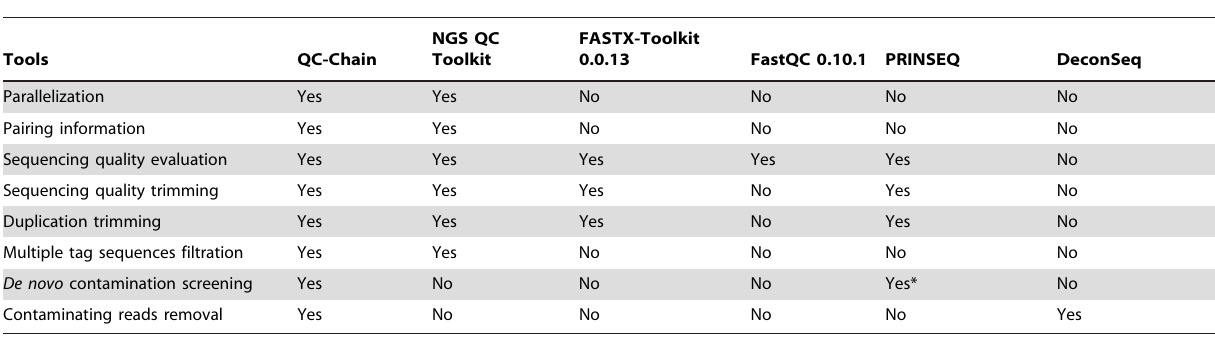
Table 4. Comparisons of key features of QC-Chain and other QC